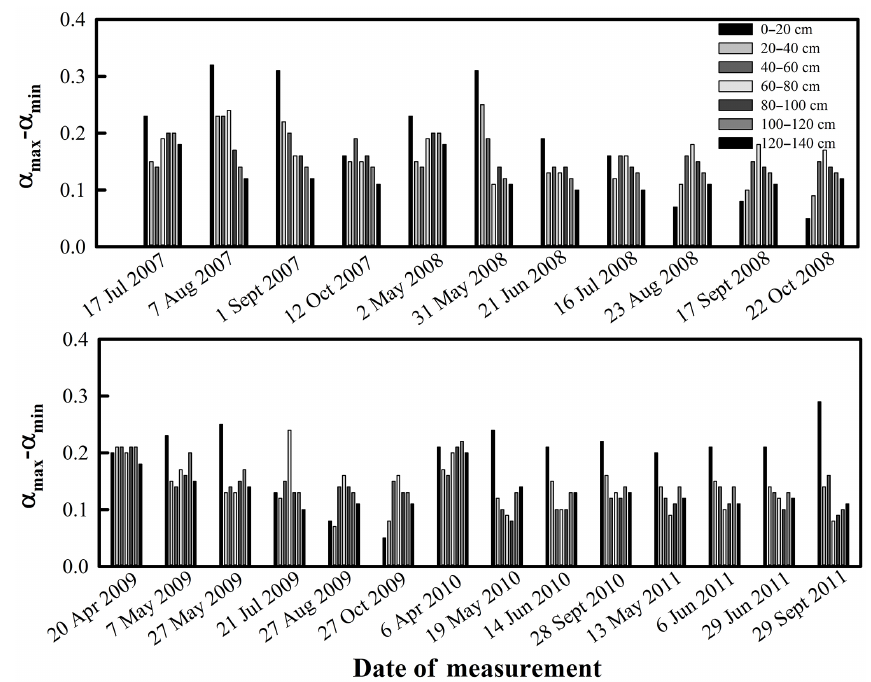
Figure 5. The width of the multifractal spectrum ( α max – α min value) for soil water storage at different depths (20cm increment) for all measurements completed during the study